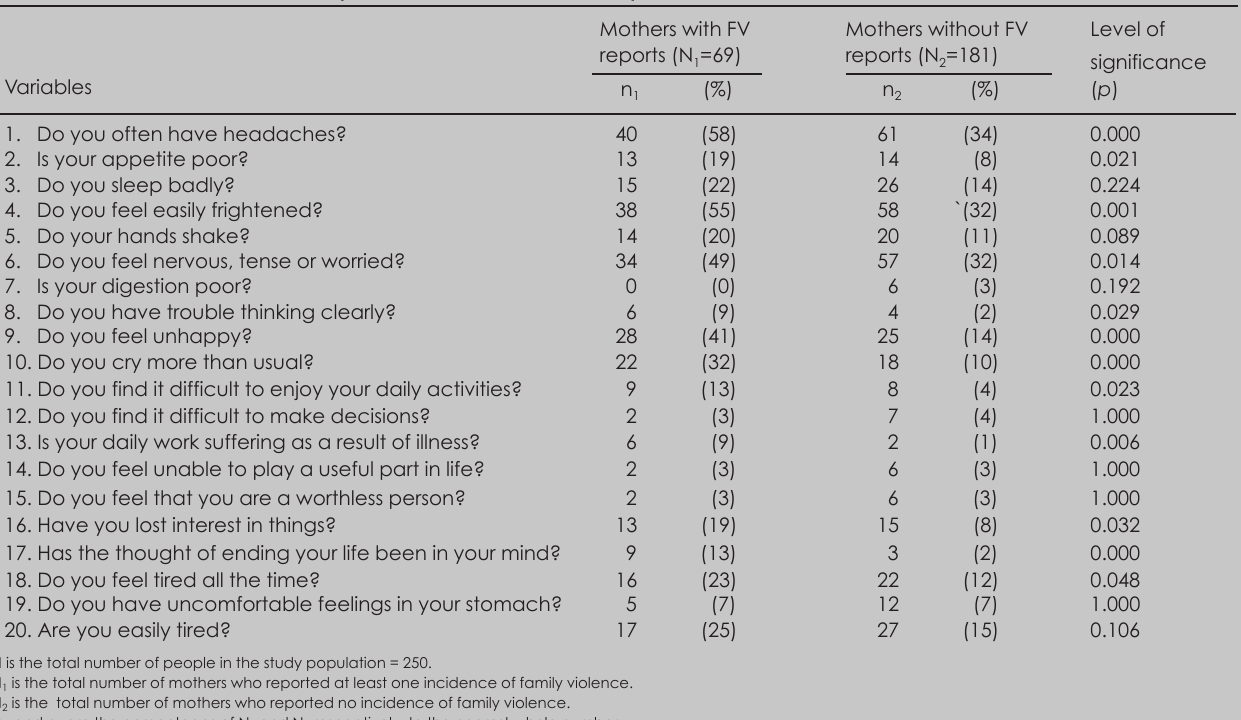
Table III. Positive items score on SRQ by mothers with and without FV report